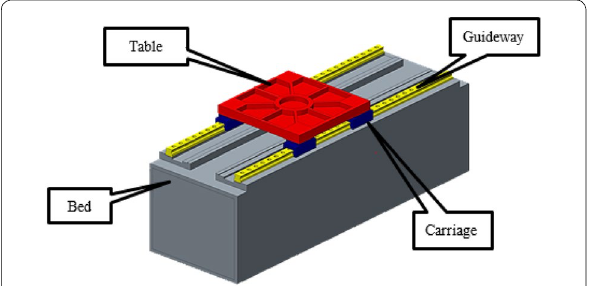
Figure 1 Joints and parts of the Z-axis